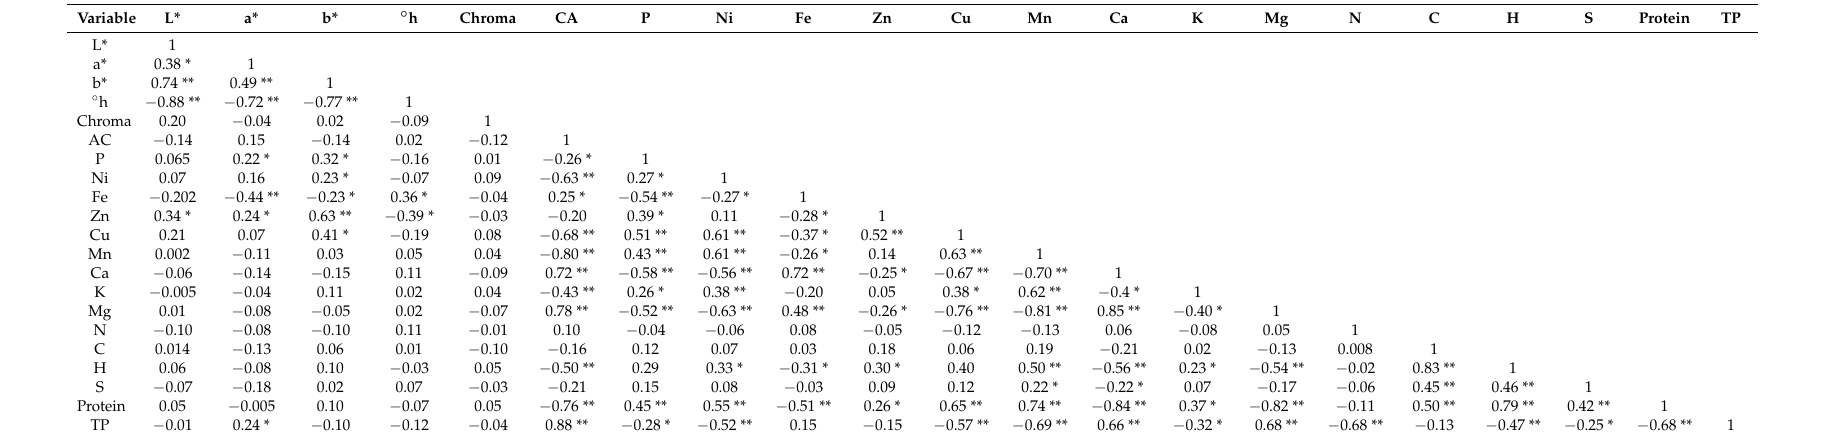
Table 7. Pearson correlation coefficients of variables evaluated in common bean